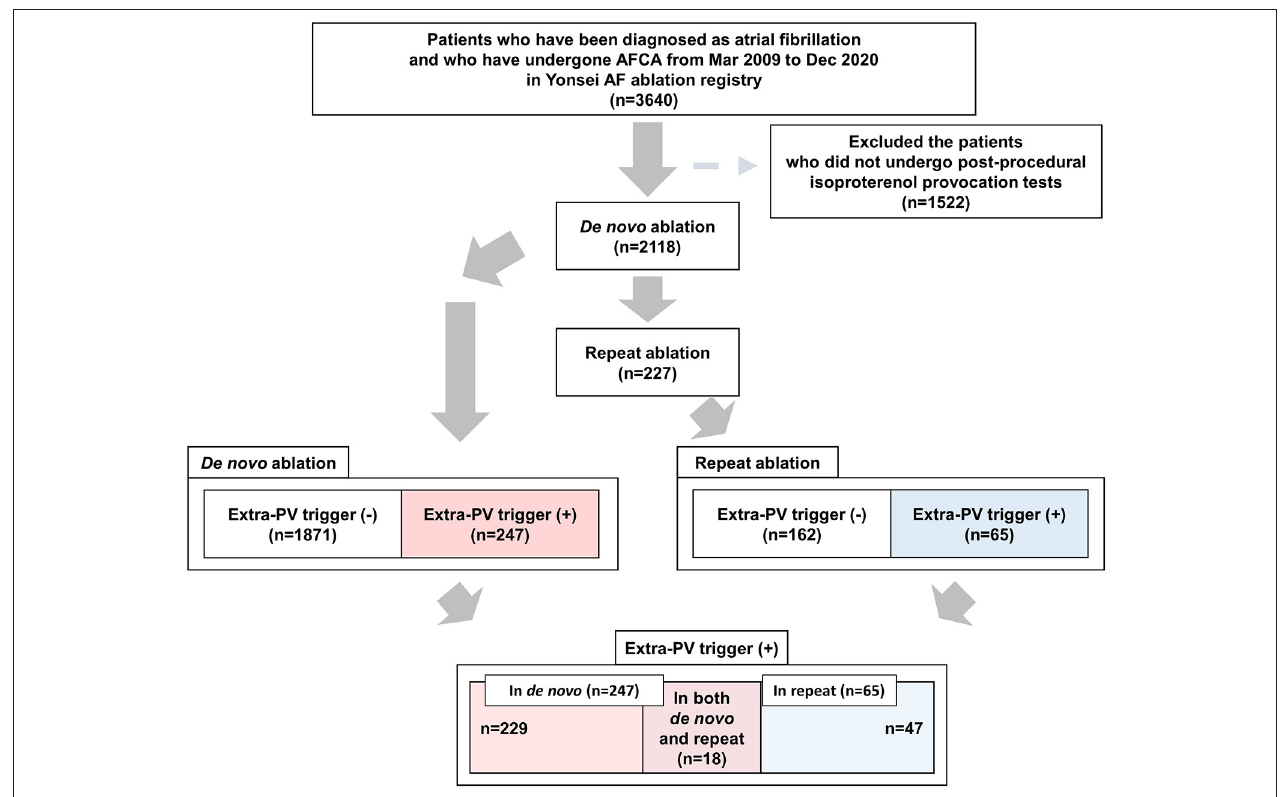
FIGURE 1 | Flow chart of the present study. AFCA, atrial fibrillation catheter ablation; PV, pulmonary vein.